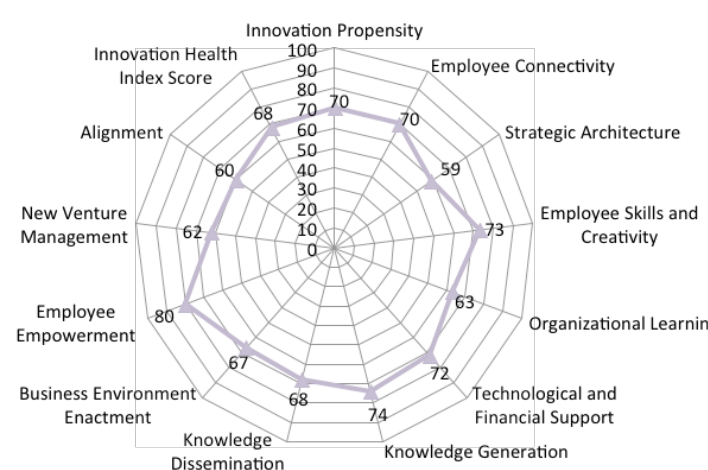
Fig. 2. F1000 12 Drivers Innovation Culture Profile (n =